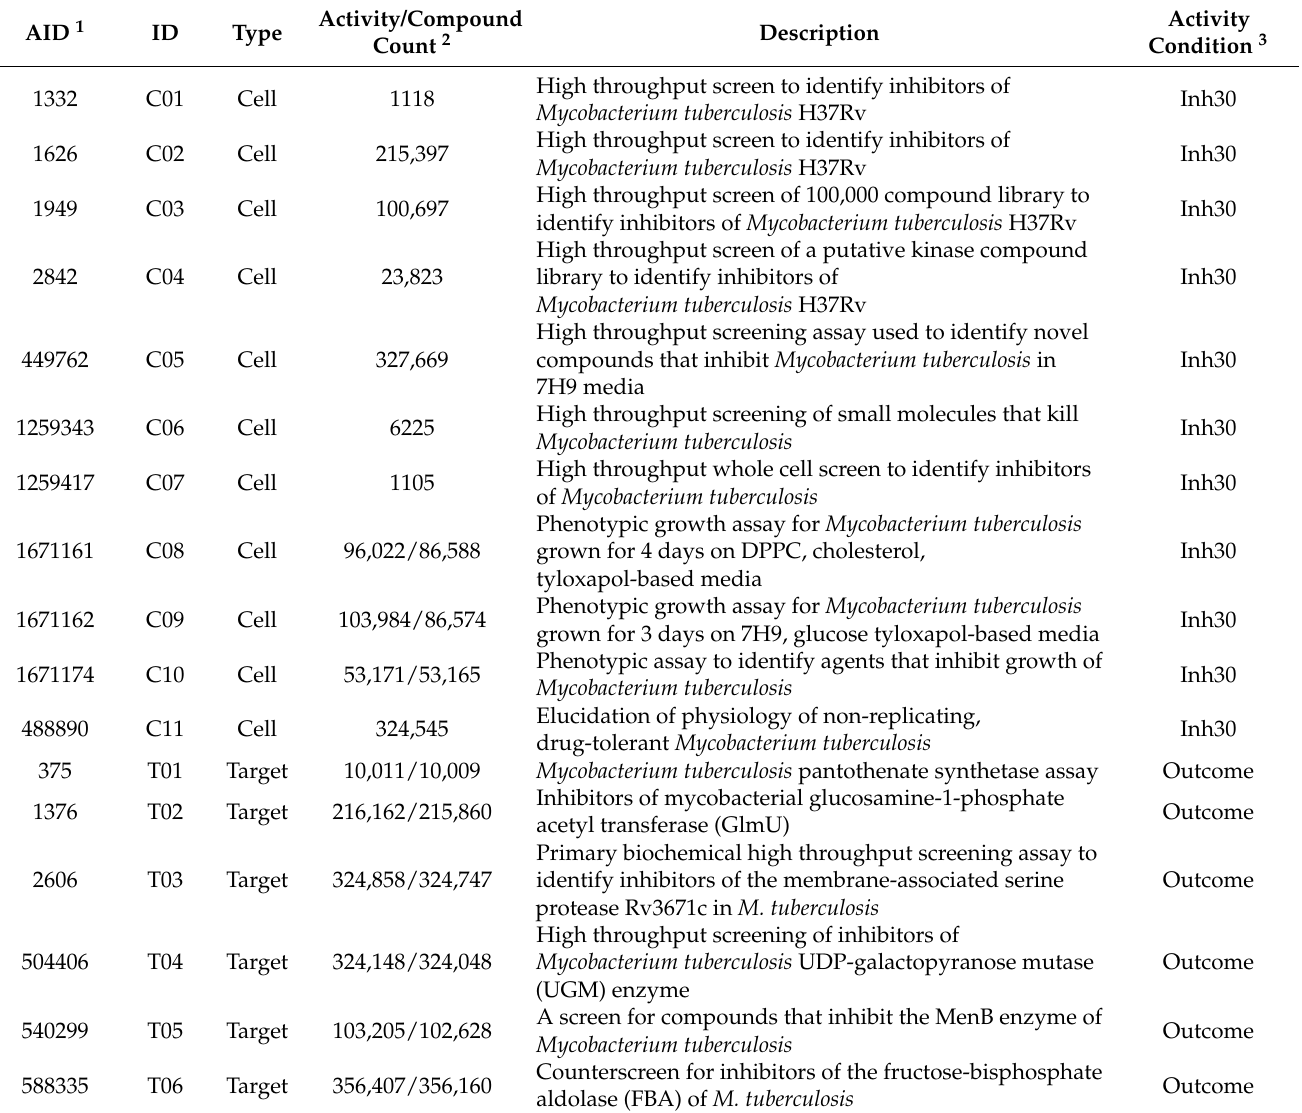
Table 2. PubChem assays used in compiling the MtbPen